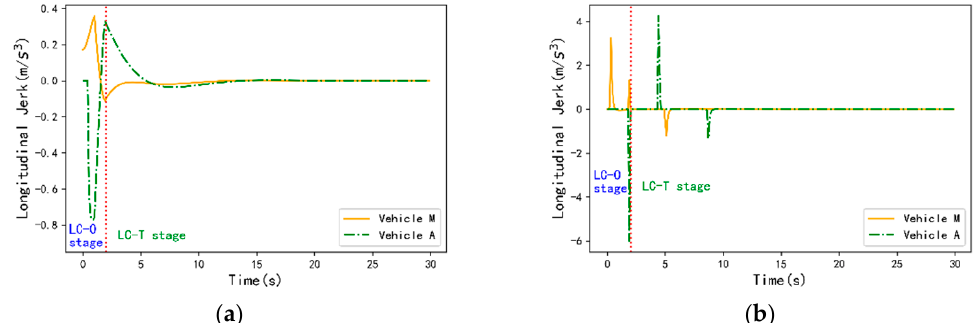
Figure 10. The longitudinal jerks of vehicles M and A of the two control strategies in scenario 1.